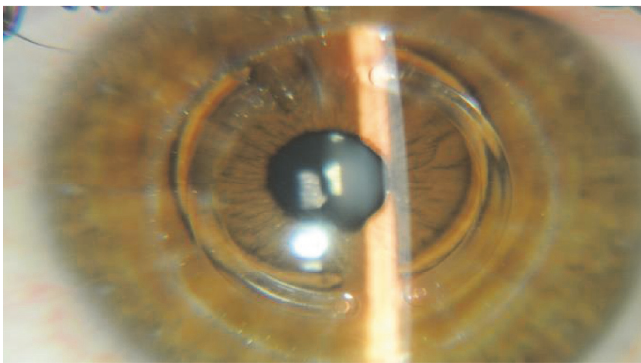
Figure 1: Transparent cornea one week after the ICRS implant.